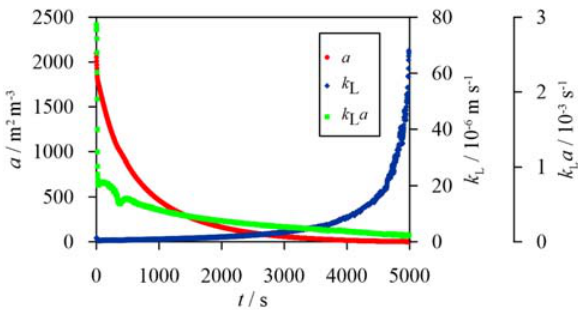
Figure 1. Relationship between interfacial area, mass transfer coef- ficient and k a product at the temperature, ϑ = 30 °C and ethanol L mole fraction, x = 0.3. Rotational frequency of the stirrer was EtOH constant for all experiments, N = 80 s –1